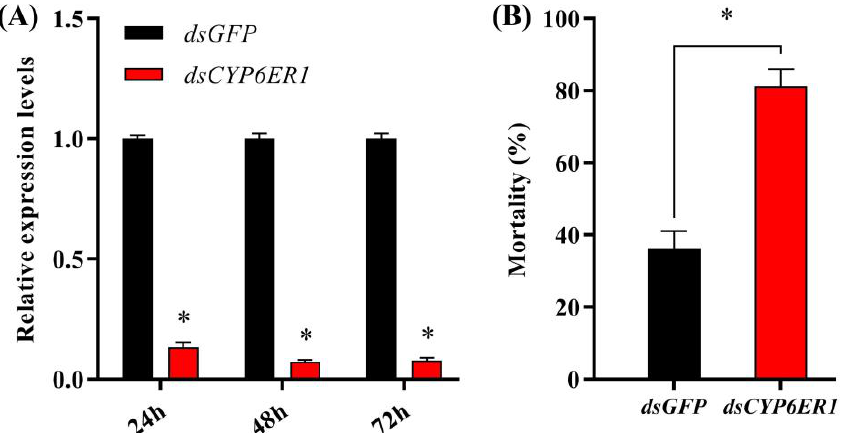
Figure 4. Functional analysis of CYP6ER1 by RNAi. ( A ) Relative expression of CYP6ER1 in fifth-instar nymphs injected with dsGFP or dsCYP6ER1 . ( B ) Mortality at 96 h of dsRNA-injected fifth-instar nymphs after treatment with acetamiprid (800 mg/L). * The asterisk indicates significant difference between the dsCYP6ER1 - and dsGFP - injected groups (Student’s t -test; p < 0.05).